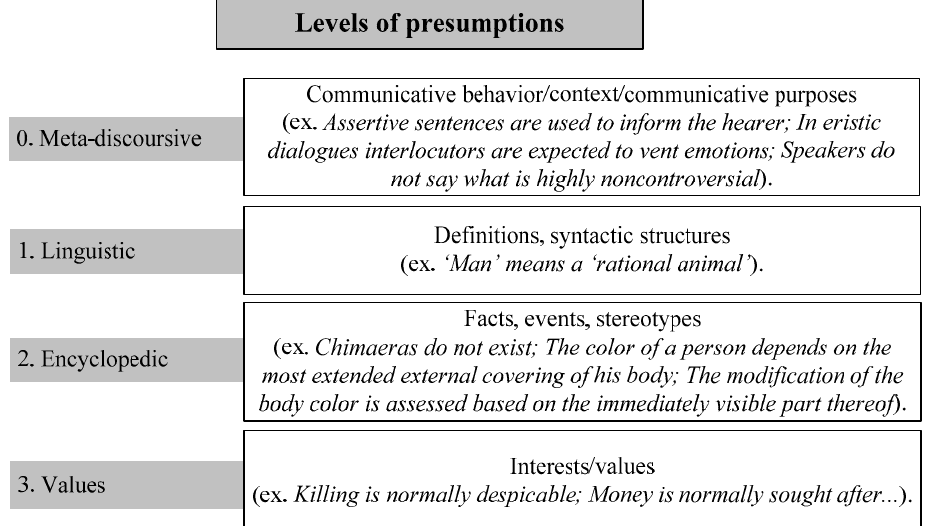
Figure 1. Levels of